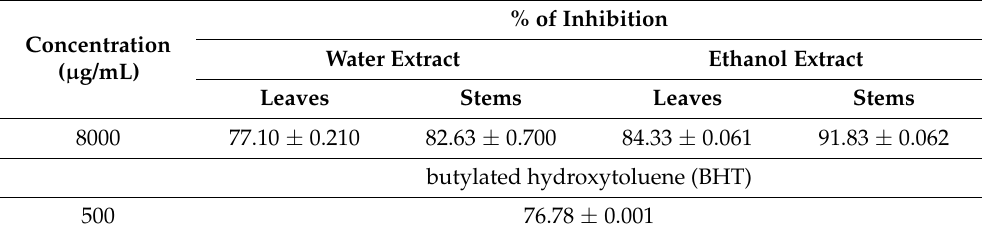
Figure 3. DPPH free radical scavenging activity curves for butylated hydroxytoluene (BHT). Table 5. Percentage of DPPH free radical inhibition of water and ethanol extracts of leaves and stems. Concentration (µg /mL)